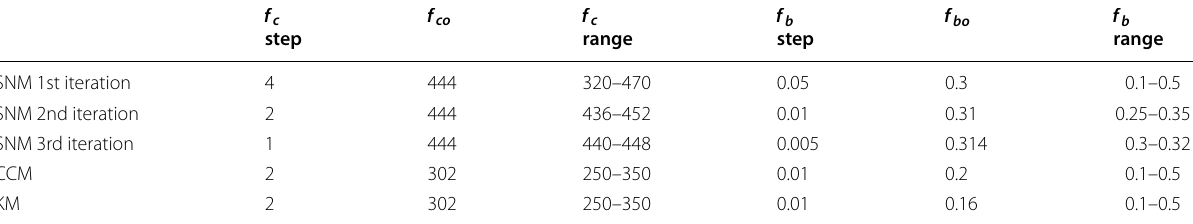
Table 6 Searching parameters